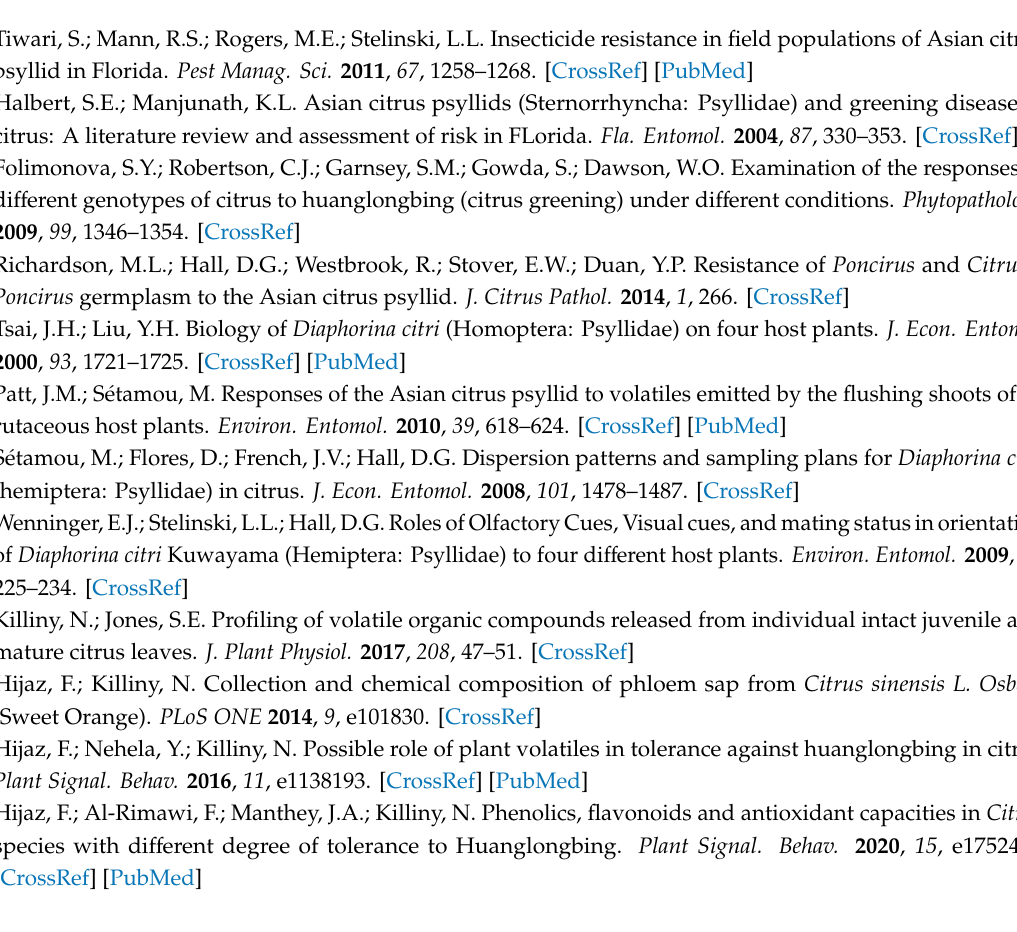
Supplementary Materials: The following are available online at http: // www.mdpi.com / 2218-1989 / 10 / 12 / 477 / s1, Table S1: Concentrations ( µ g · g − 1 FW) of the major polar metabolites detected in leaves of C2-5-12 Pummelo ( Citrus maxima ), C. latipes , and three corresponding sexual hybrids after derivatization with TMS and using gas chromatography-mass